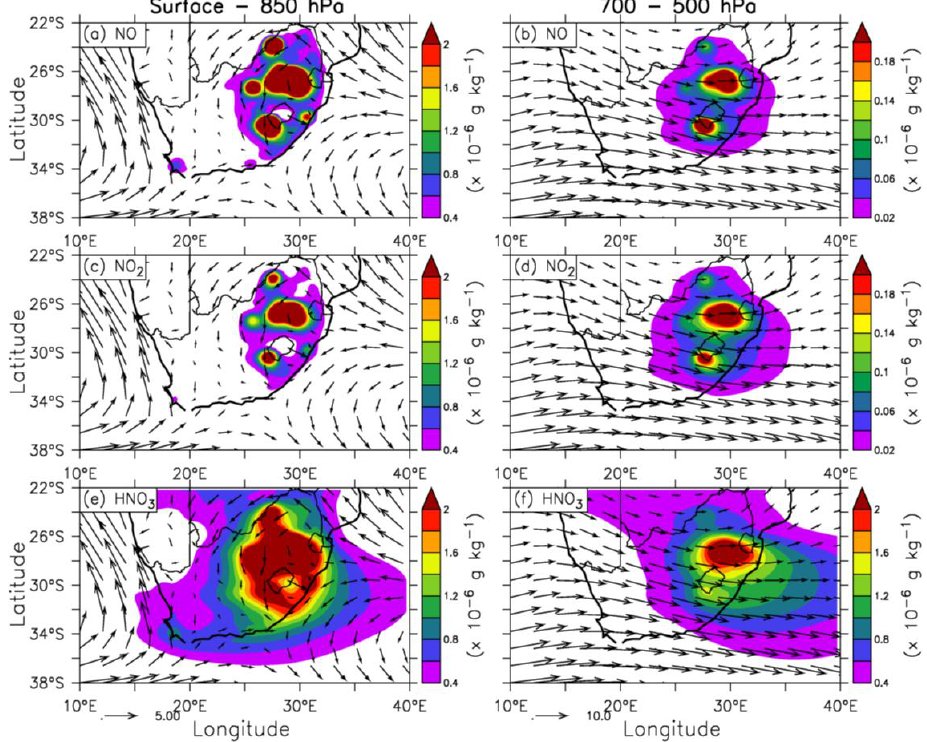
Figure 8: RegCM4 simulated annual mean (2001–2004) concentration for NO ( × 10 − 6 gkg − 1 ; top panels), NO 2 ( × 10 − 6 gkg − 1 ; middle panels) and HNO 3 ( × 10 − 6 gkg − 1 ; bottom panels) at low level (surface–850hPa; left panels) and middle level (700–500hPa; right panels) over South Africa. The corresponding wind speeds are shown with arrows; the arrows at the bottom of the bottom panels ( e and f ) show the wind scale of 5ms − 1 and 10 m s − 1 , respectively.